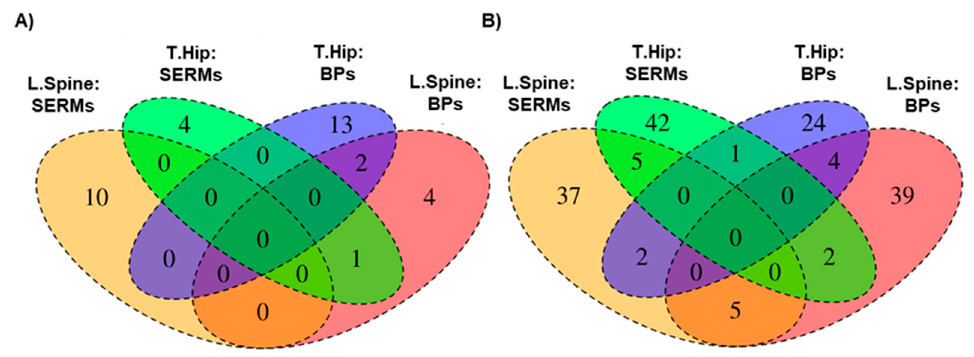
Figure 4. Venn diagrams displaying the intersections between the genome association analyses in